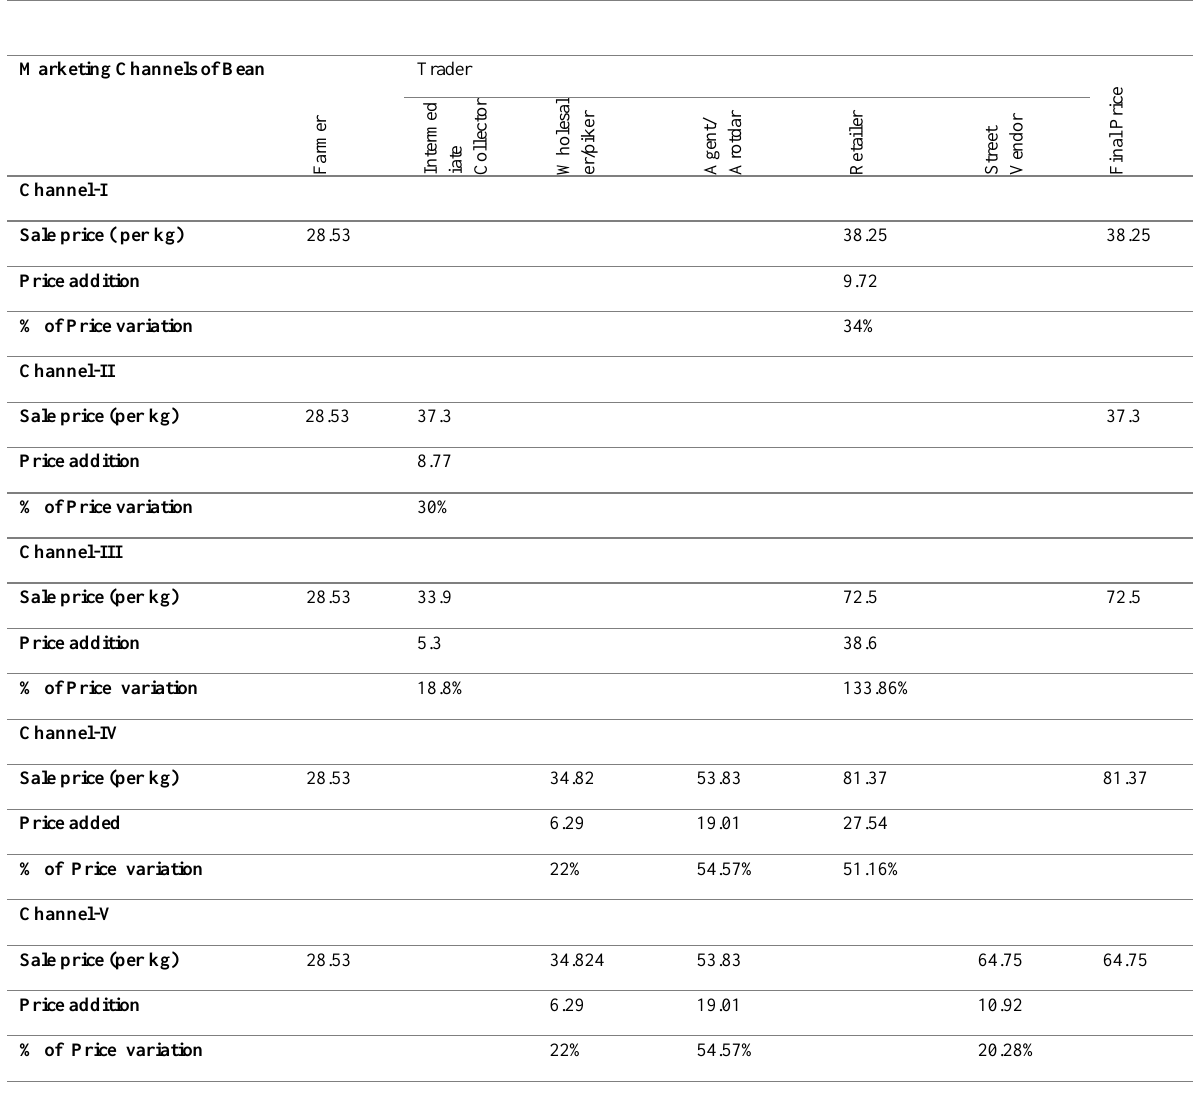
Table 3: Nature of Price Variations in Different Marketing Channels of